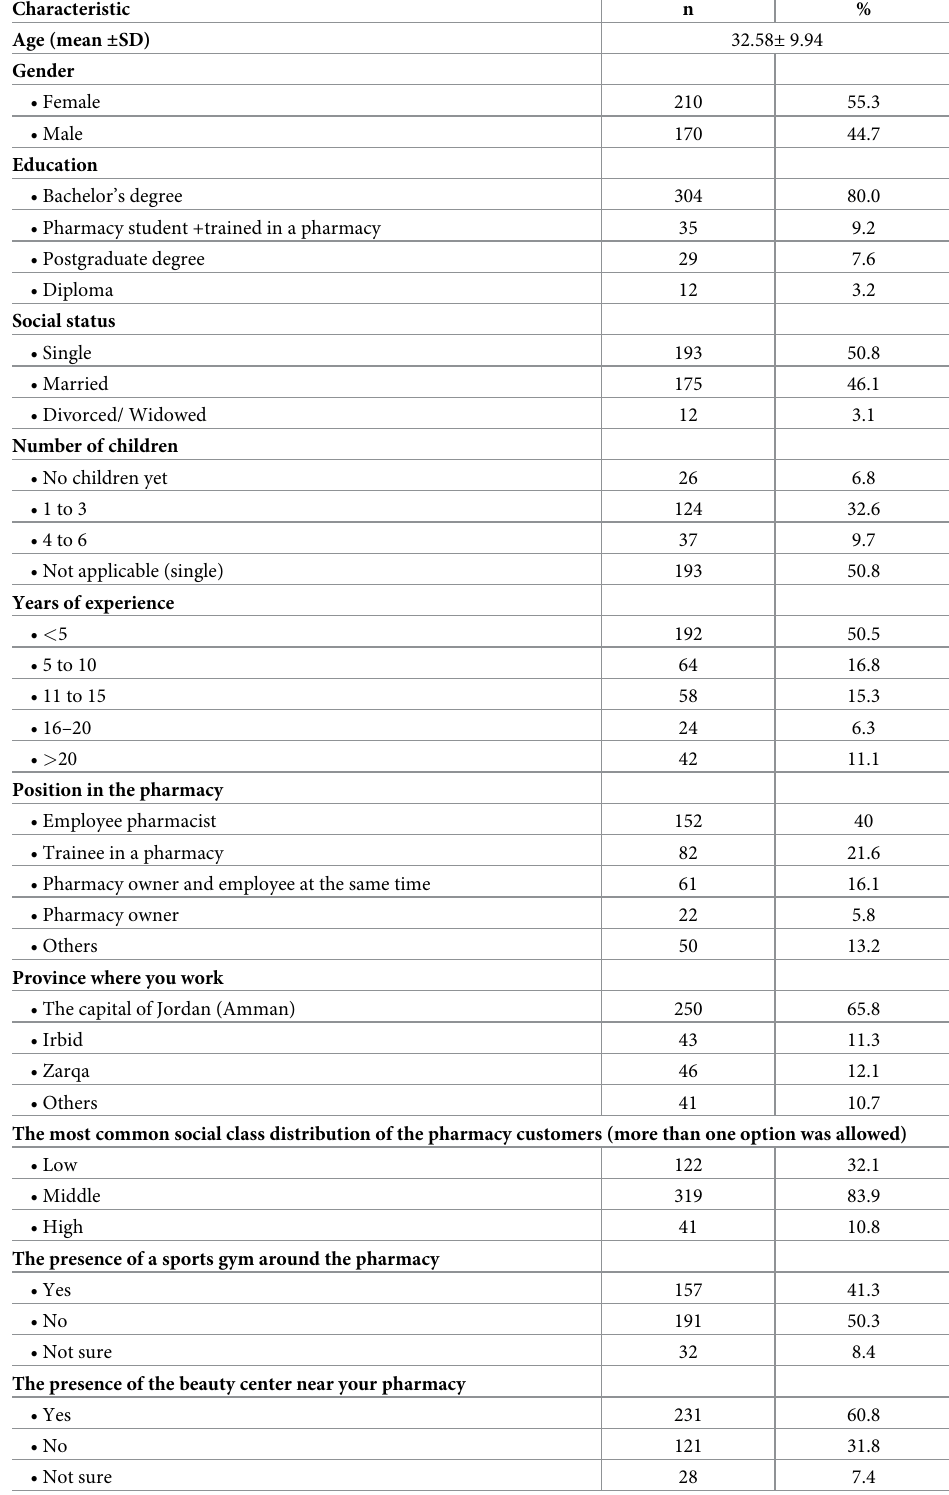
Table 1. Sociodemographic characteristics of the participants (n =